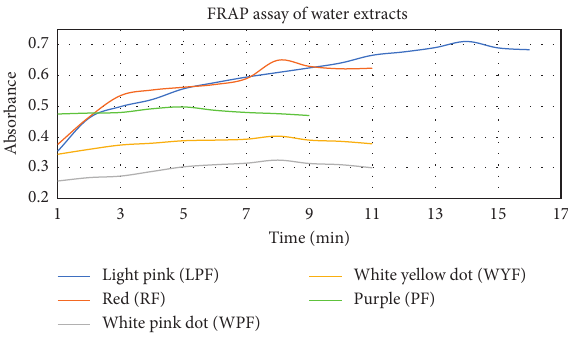
Figure 14: FRAP of the water extracts.